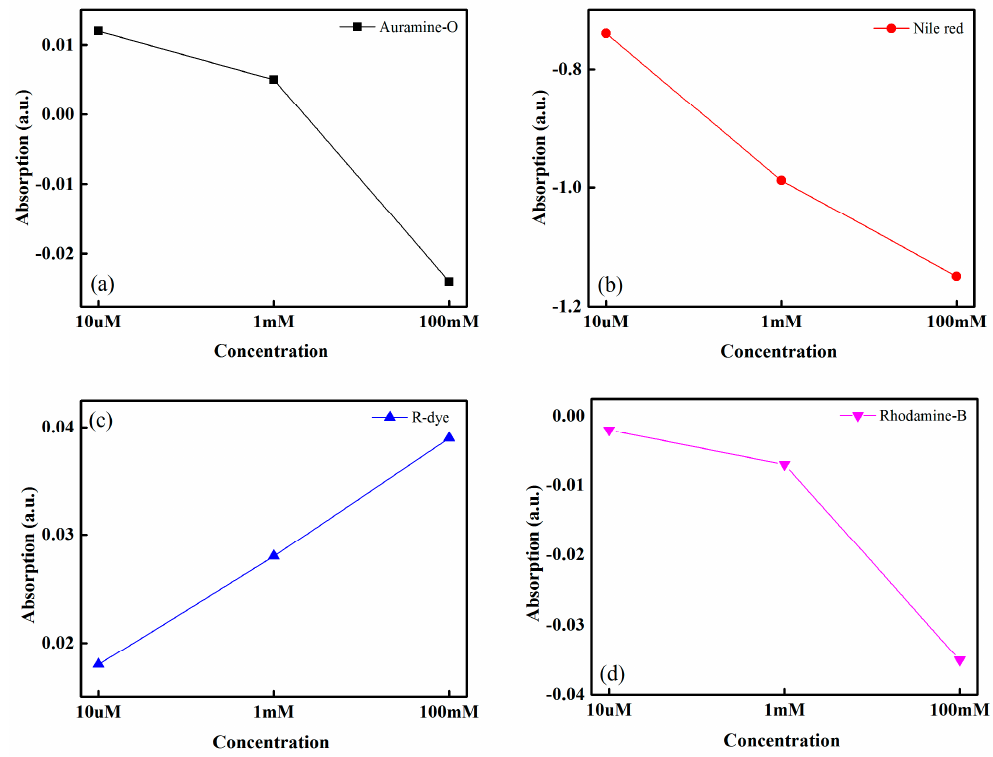
Figure 5. Optical absorption performance of the different dye containing glucose solution: ( a ) Auramine O; ( b ) Nile-red; ( c ) Reichardt’s dye; and ( d ) Rhodamine B.